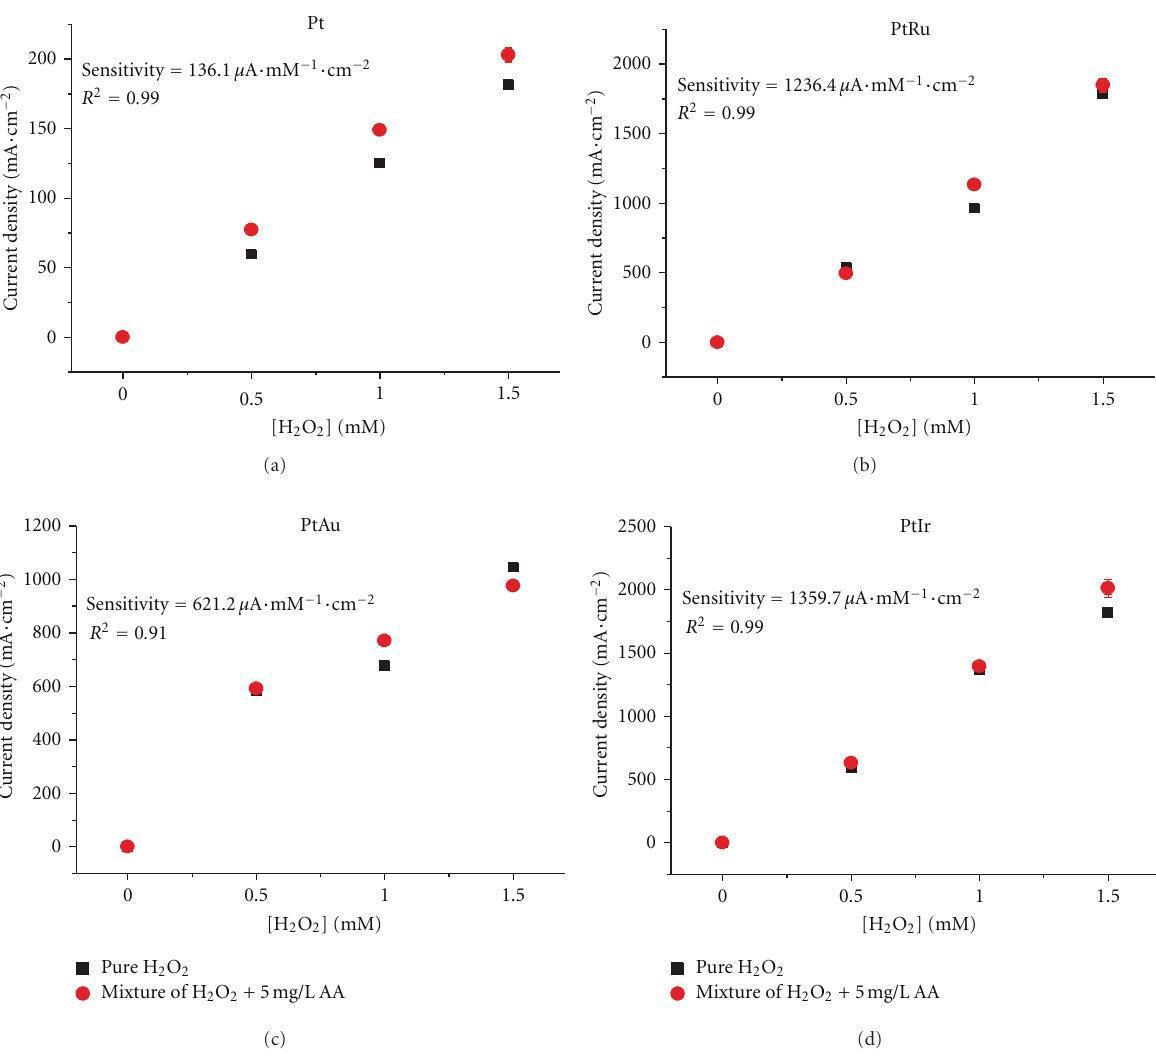
Figure 7: E ff ect of 5mg/L AA to H 2 O 2 detection at +0.3V versus